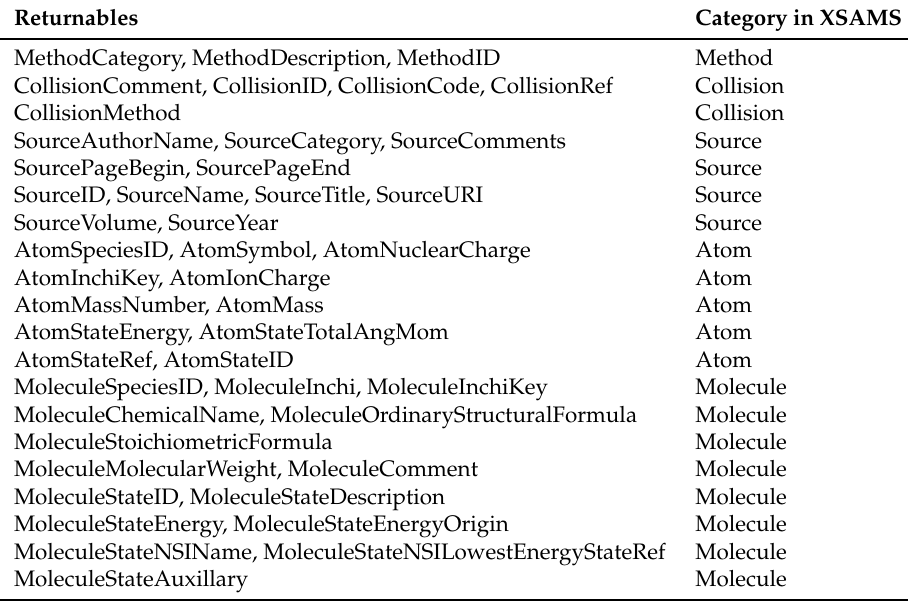
Table 8. List of BASECOL Returnables metadata on the date of